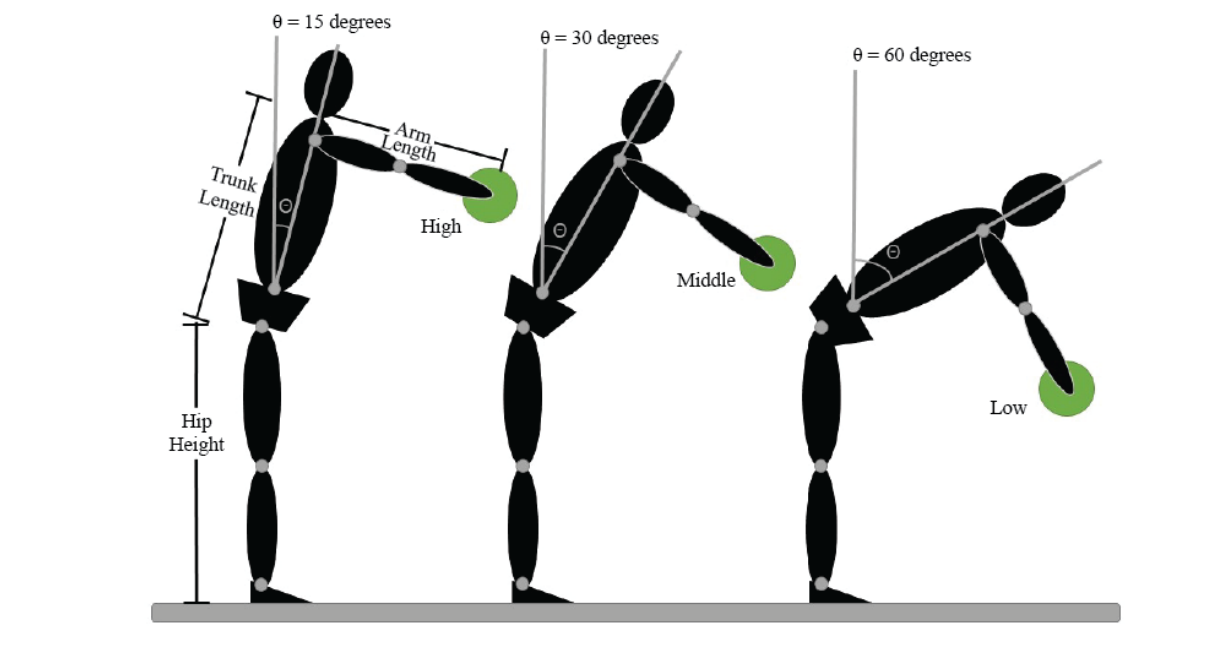
Figure 3. Methods for computing location of the impact heights (IH1: highest; IH3: lowest) of the launched virtual balls for a single game level. Impact heights were tailored for each participant based on their hip height, trunk length, and arm length to varying degrees of lumbar spine